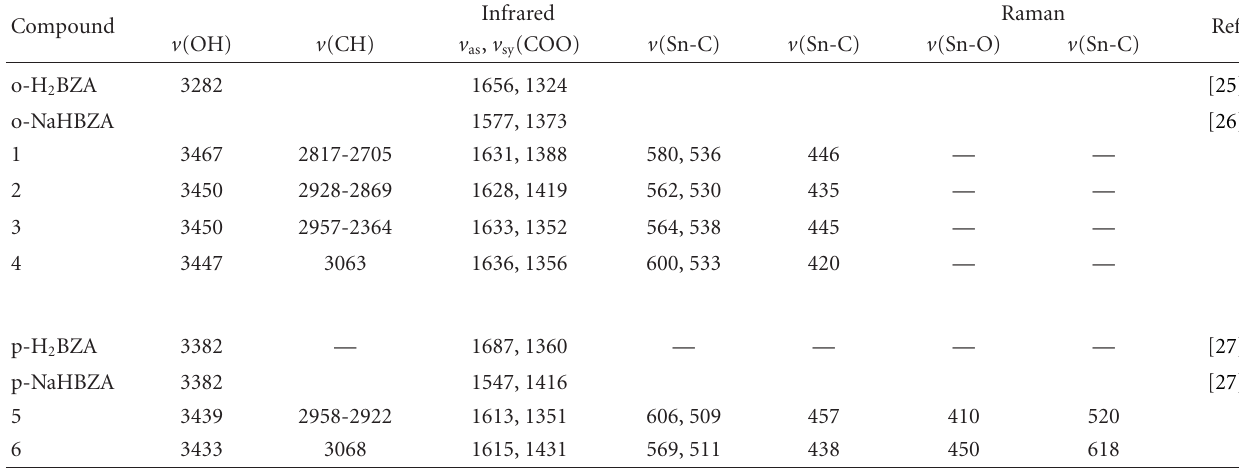
Table 1: Characteristic vibration bands (cm − 1 ) of the o- or p-HBZA ligands and their complexes 1 – 6.